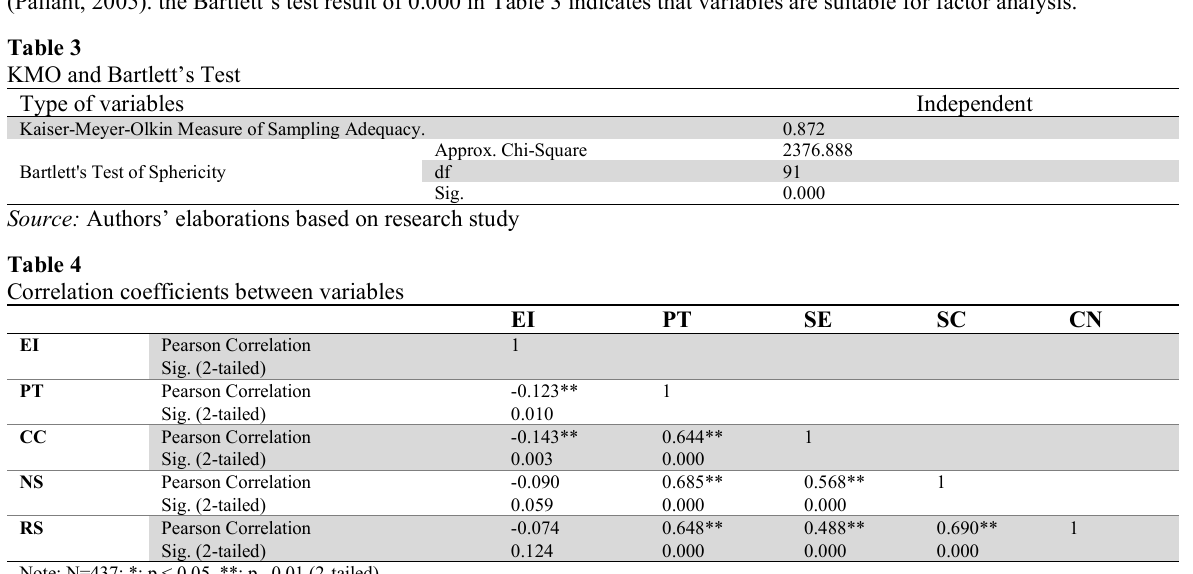
KMO and Bartlett’s Test Type of variables Independent Kaiser-Meyer-Olkin Measure of Sampling Adequacy.